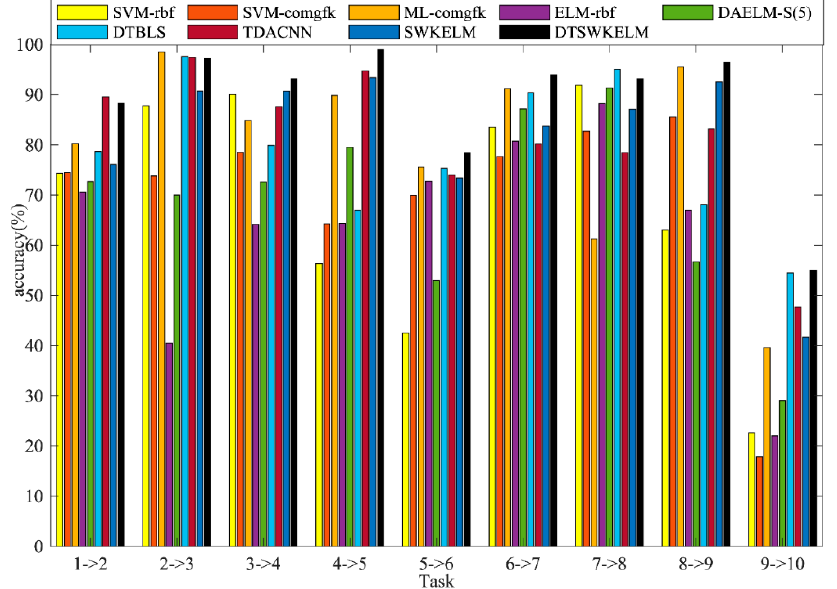
Figure 5. The histogram of the recognition effect of each algorithm in Experiment 2.